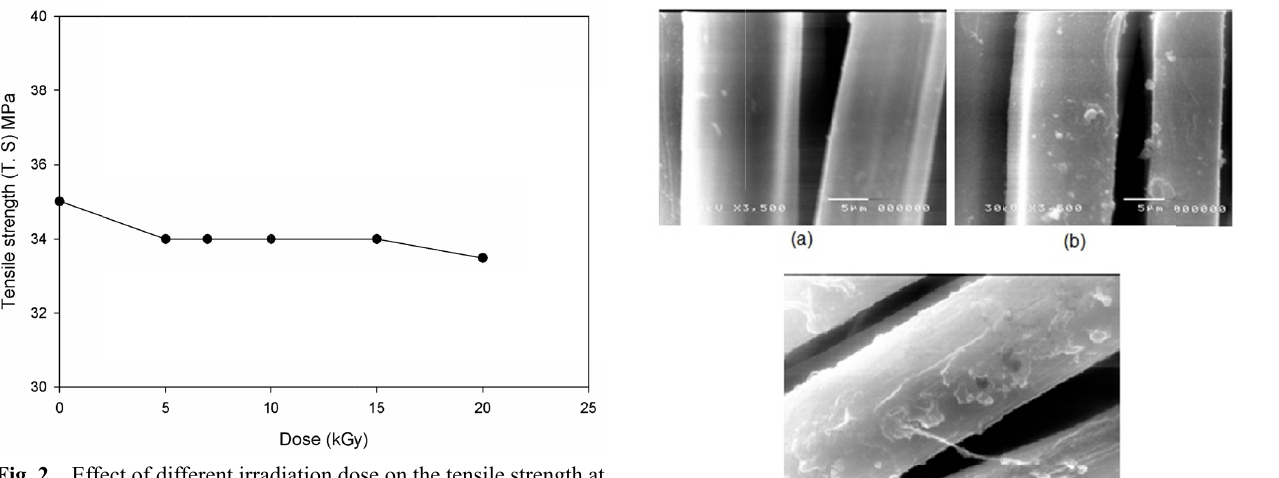
Fig. 2. Effect of different irradiation dose on the tensile strength at break of untreated silk fabric and AgNPs-treated ones with different gamma irradiation doses.